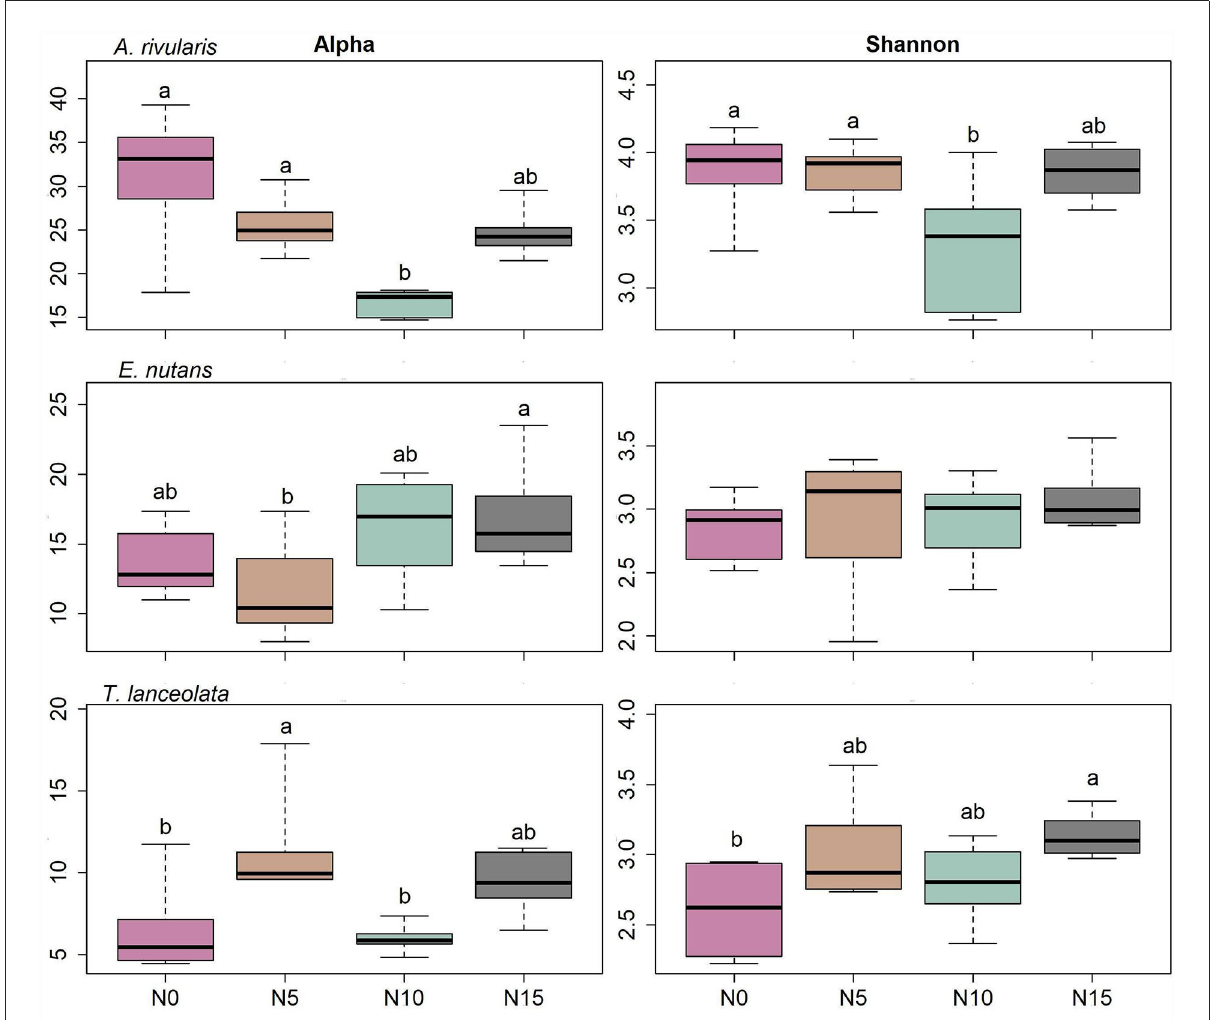
FIGURE3 Diversity patterns of the fungal community within each host against N gradients. Alpha is the number of observed species, and Shannon is the Shannon diversity index. The sequences were rarified to 1,944, n = 71. Significant differences of each variable are indicated by dissimilar letters above boxes. N0, N5, N10, and N15 referring to 0, 5, 10, and 15g N (NH 4 NO 3 ) m − 2 yr − 1 treatments,